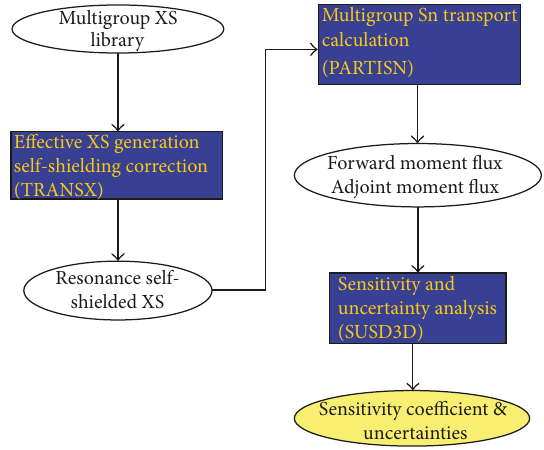
Figure 1: XSUN-2017 computer code